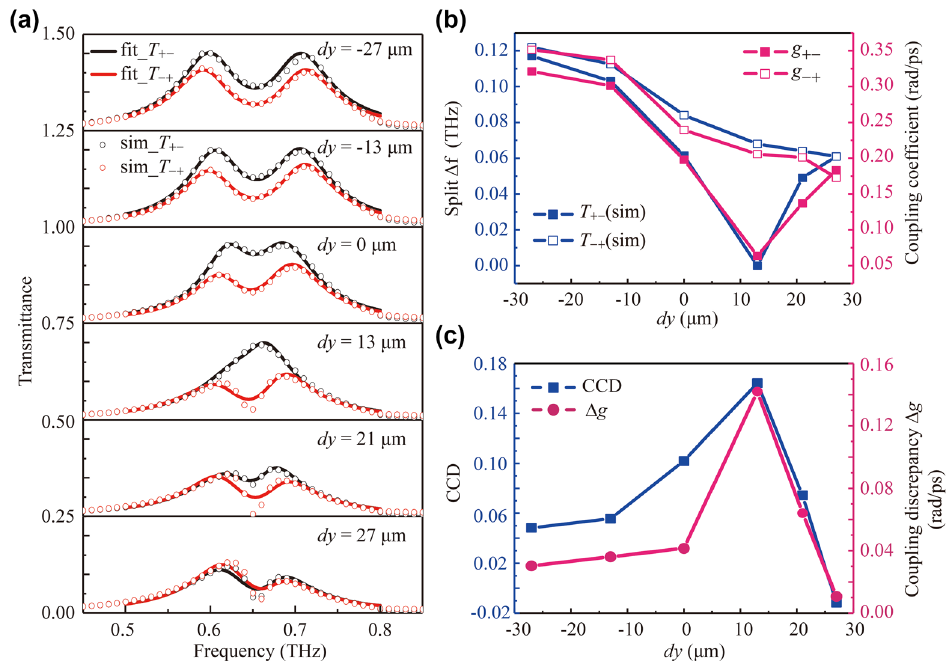
Figure 5: Theoretical analysis results of the coupling enabled chirality. (a) Fitted (solid line) and simulated (open dotted) spectra of the metasurfaces type-I with varying dy . (b) Spectral splittings and the coupling coefficients of T +− and T −+ . (c) CCD and the coupling discrepancy Δ